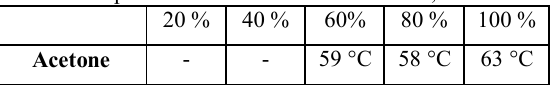
Fig. 13. Electrotechnical box temperature stabilization. Table 1. Temperature in the electrotechnical box, load 500 W.